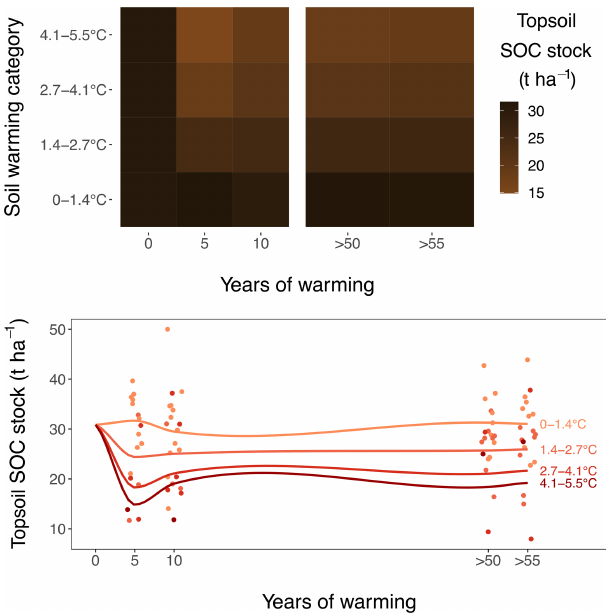
Figure 2. Warming effect on topsoil (0–10cm) SOC stocks, as observed during repeated sampling campaigns. Stocks after 5 and 10 years of warming are sampled in the medium-term warmed grasslands and stocks after > 50 and > 55 years in the long-term warmed grasslands. The data at the start of warming are interpo- lated from the ambient plots in grasslands combined. Soils are di- vided into four warming categories for representation. The colours on the heatmap and the smoother lines are based on a linear regres- sion equation per sampling event.